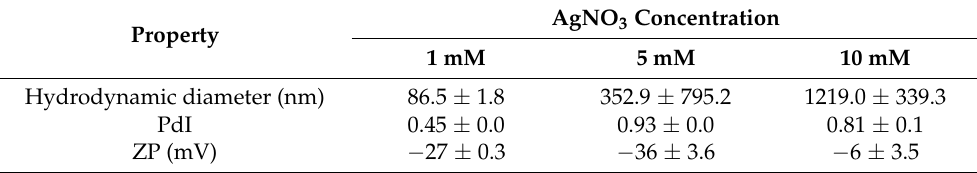
Table 1. Hydrodynamic diameters, zeta potential (ZP), and polydispersity index (PdI) of AgNPs prepared using different concentrations of AgNO 3 (1, 5, and 10 mM), and synthesized using B. flexuosa leave